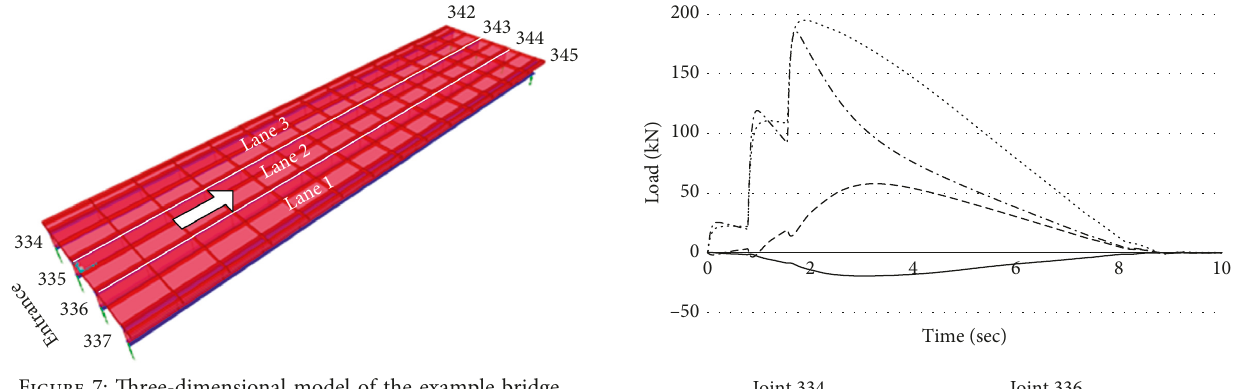
Figure 7: Three-dimensional model of the example